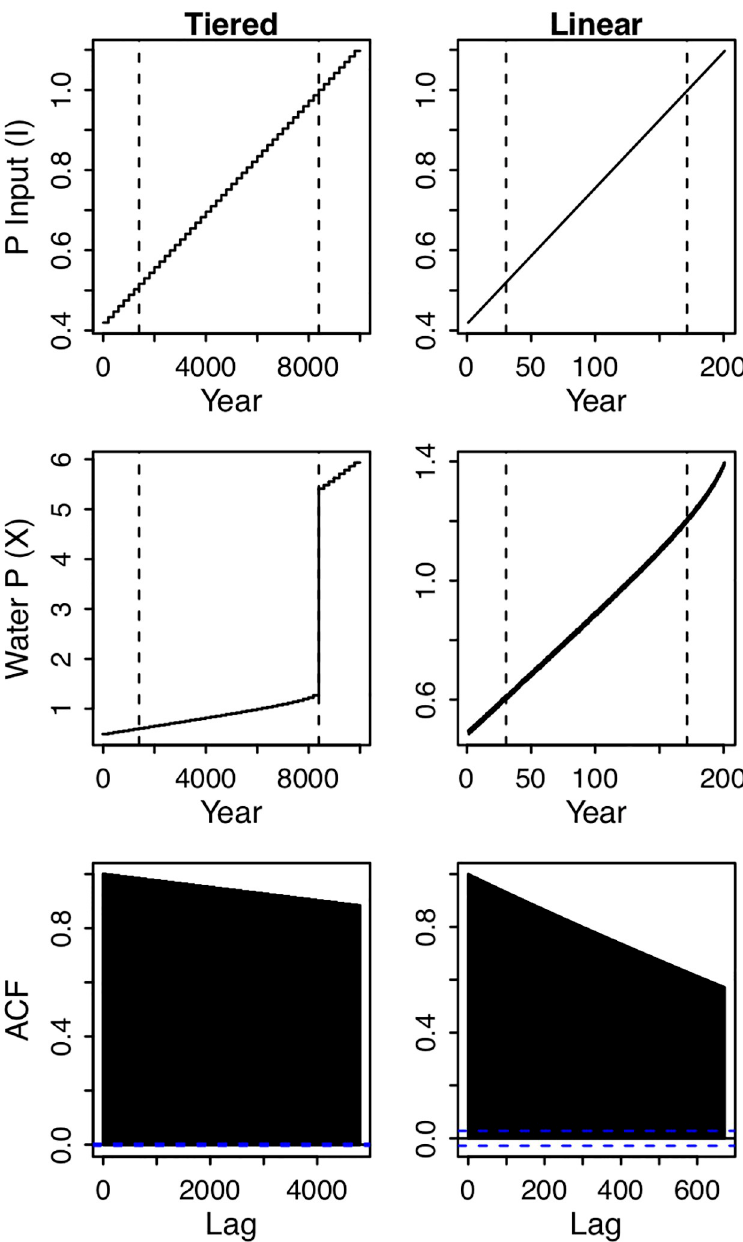
Fig 2. Time series of simulated lake phosphorus. Simulations included 24 observations per year for the entire period of study. The first row shows time series of phosphorus input ( I ), the second row water phosphorus (X), and the third row the autocorrelation function. The left column of panels contains results from a simulation in which I was increased in a stepwise fashion; the model was initiated at equilibrium at the start of each tier of P input, each of which lasted 200 years. The maximum number of lags in the bottom-left panel is equal to the number of observations in 1 tier of P input (200 � 24). The right column of panels contain results from a simulation in which P input is increased smoothly and linearly over time; each time step has slightly higher I than the previous. The number of lags in the bottom-right panel are equal to the number of observations in 28 years. The vertical dashed lines indicate the times at which alternate equilibria emerge (a stable node and a saddle point), and when the original equilibrium (a stable node) is annihilated as it collides with a saddle point (see Fig 1). Both simulations are stochastic, but the simulation on the right includes an additional sinusoidal process. The simulation with smooth and linear increases in I (right) does not show an abrupt increase in X because the system is lagging behind its equilibrium value, which changes with I